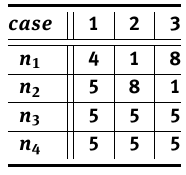
Table 5. n = 38 with one n i in M ∆